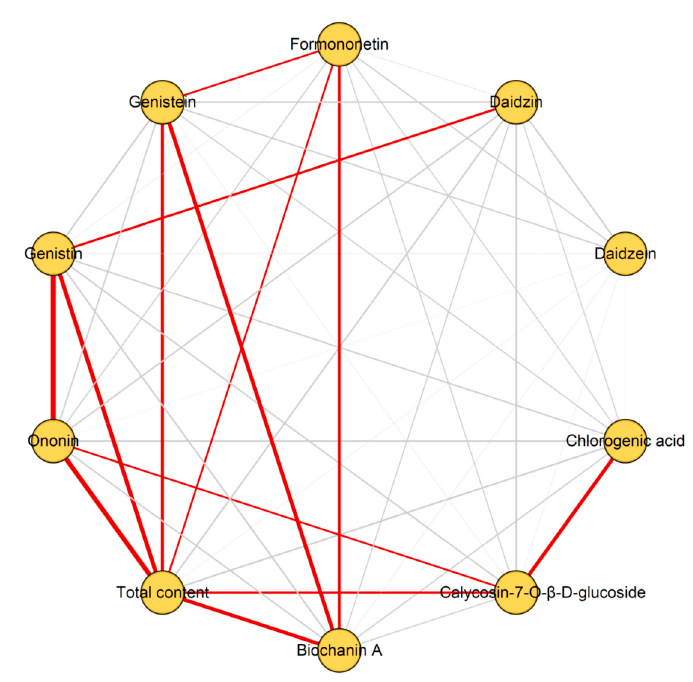
Figure 5. Correlation network for the contents of the nine compounds and the total contents detected in red clover. The significant correlations ( | r | > 0.50 and p < 0.05) are indicated with red lines. The positive correlations are indicated with solid line. The negative correlations are indicated with dotted lines. The weak correlations ( | r | < 0.50) are indicated with grey lines. Thicker lines indicate a stronger correlation. The length of each line has no meaning.